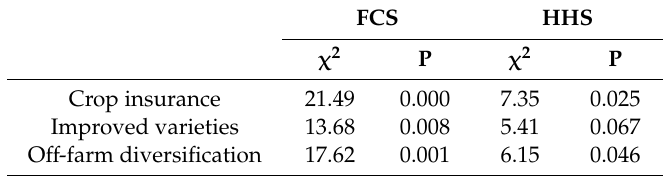
Table 3. Chi-squared results of food security. FCS, food-consumption score; HHS, household hunger